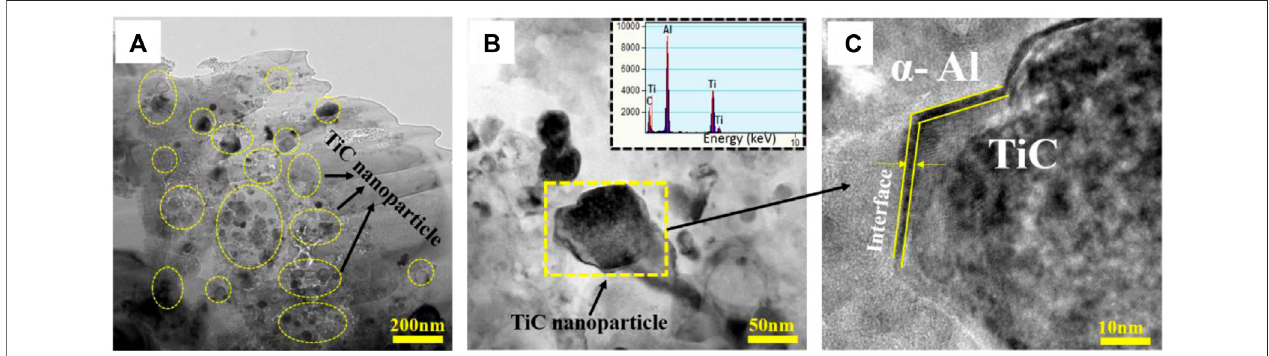
FIGURE 9 | (A) and (B) TEM images illustrating the TiC nanoparticle distribution within the a-Al matrix of TiC/2219 nanocomposites; (C) Enlarged area in b.